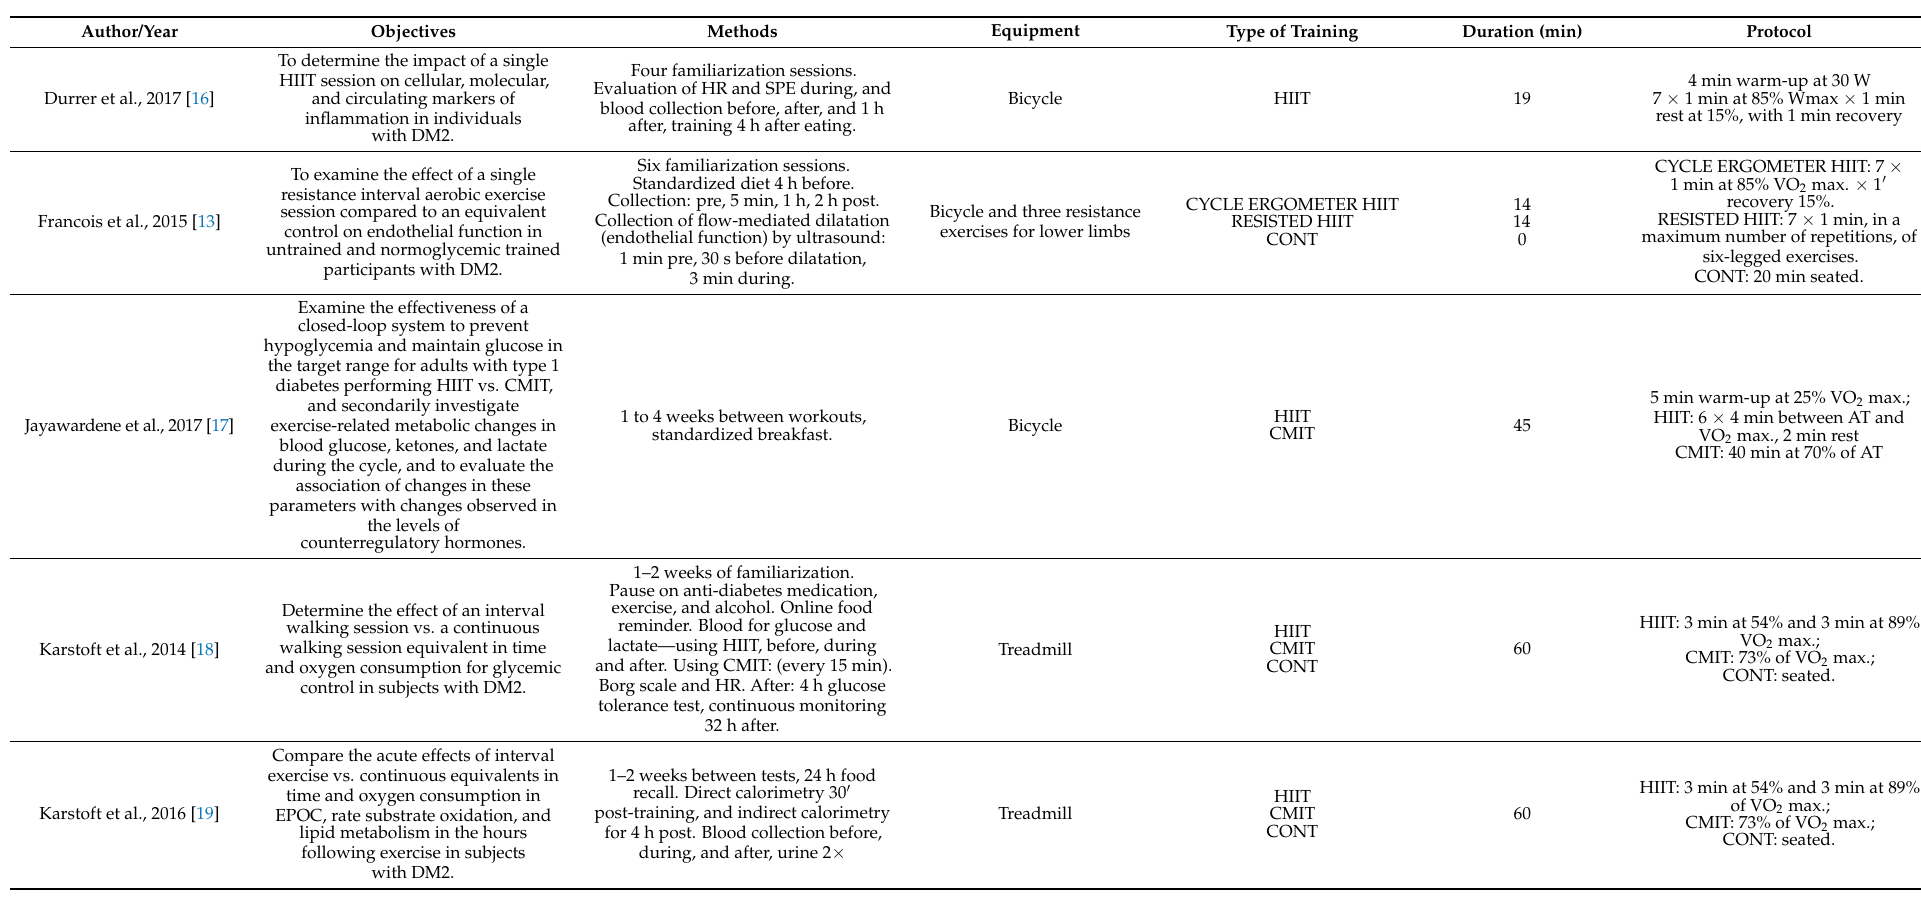
Table 3. Study training methods and